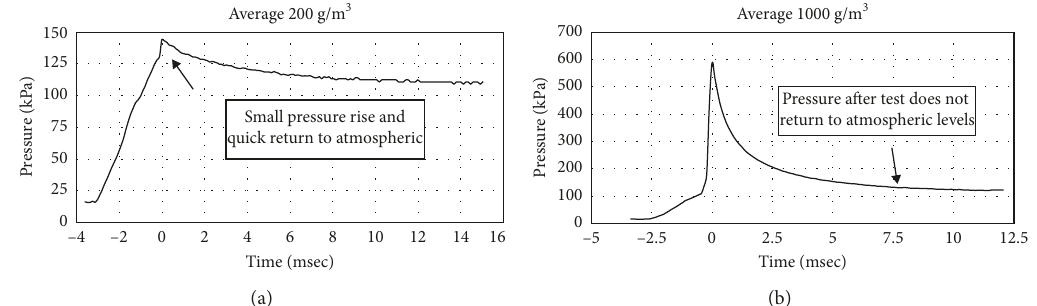
Figure 6: Comparison of under-fueled (a) and over-fueled (b) coal dust tests.